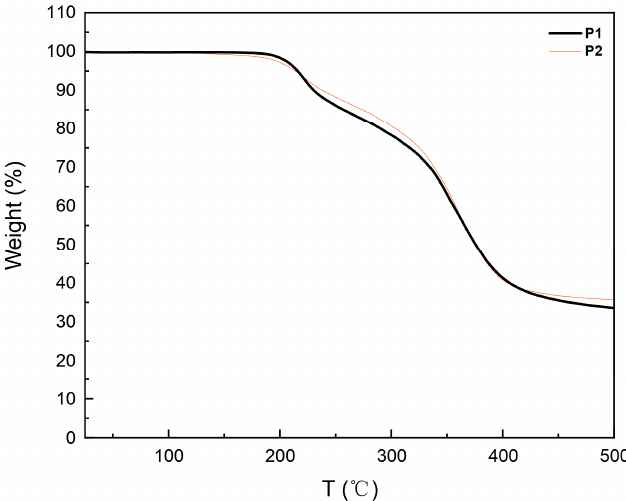
Figure 2. TGA curves of P1 and P2 at the heating rate of 10 °C min − 1 under flowing nitrogen.